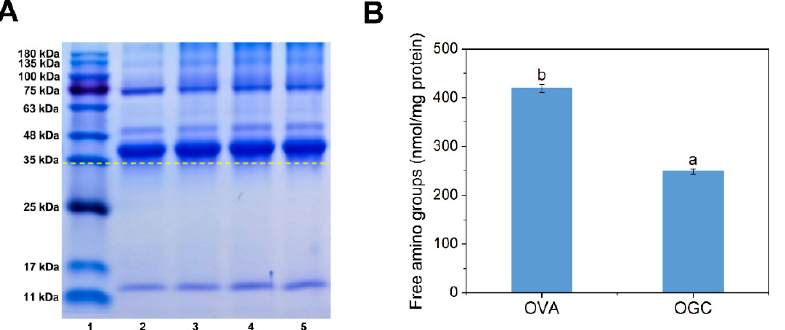
Figure 3. ( A ) SDS-PAGE profiles of OVA and OGC with different heat treatment times (24 h, 48 h and 96 h). Lane 1, protein marker; lane 2, OVA; lane 3, OGC heated for 24 h; lane 4, OGC heated for 48 h; lane 5, OGC heated for 96 h; ( B ) Free amino groups of OVA control and OGC heated for 96 h. Mean values ( n = 3) with different lowercases represented significant differences ( p <